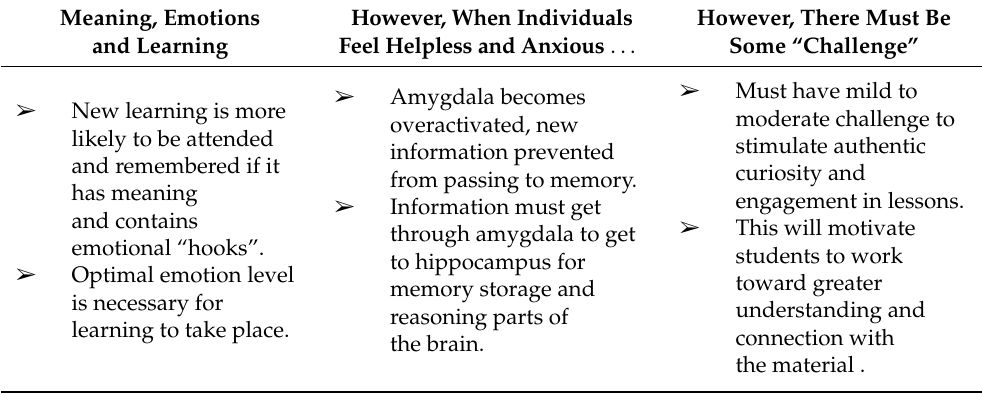
Table 1. The Requirement for the integration of meaning, emotions, and learning. Meaning,